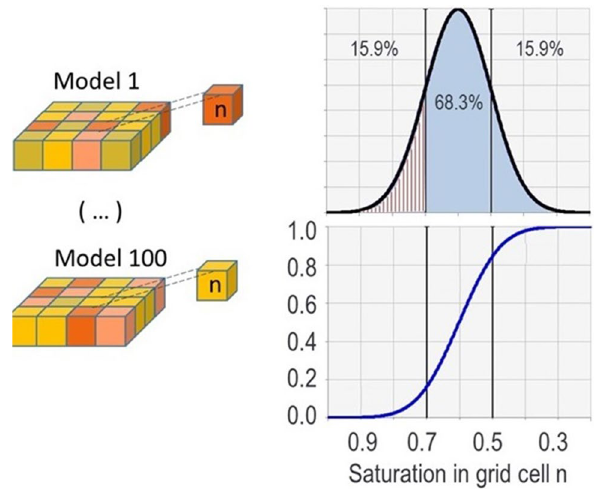
Fig. 7 Concept for calculating probability